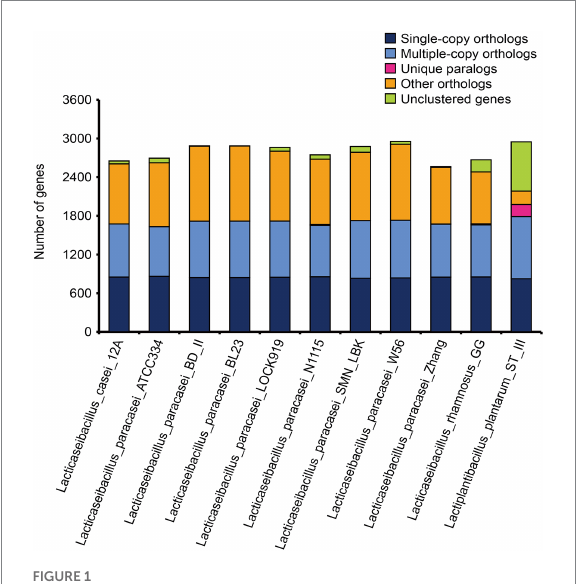
FIGURE 1 Bar chart of orthologs and paralogs in each